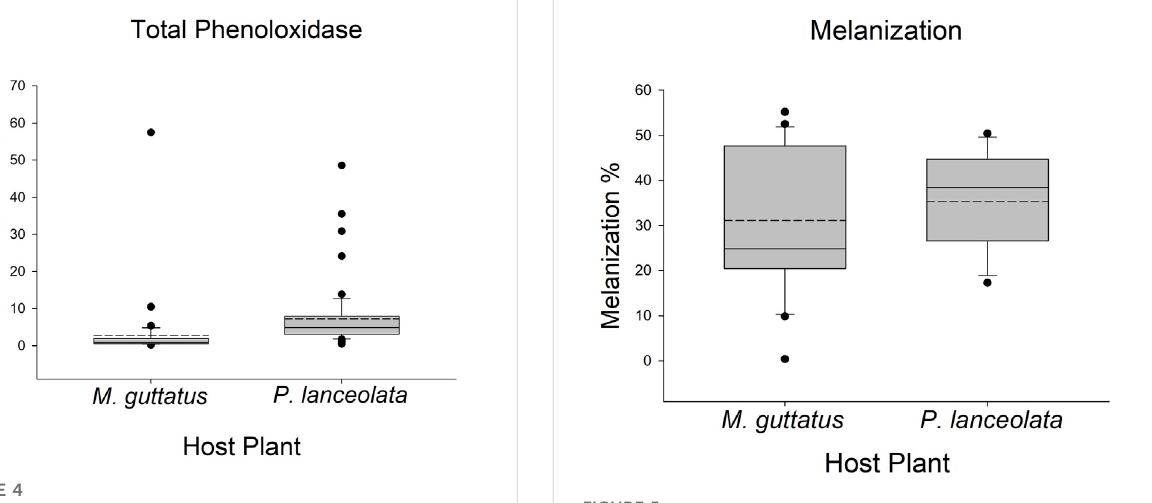
FIGURE 5 Boxplots representing the data for melanization for each host plant. Solid lines in the boxes represent the median melanization and dotted lines represent the mean melanization. Melanization was higher on Plantago lanceolata